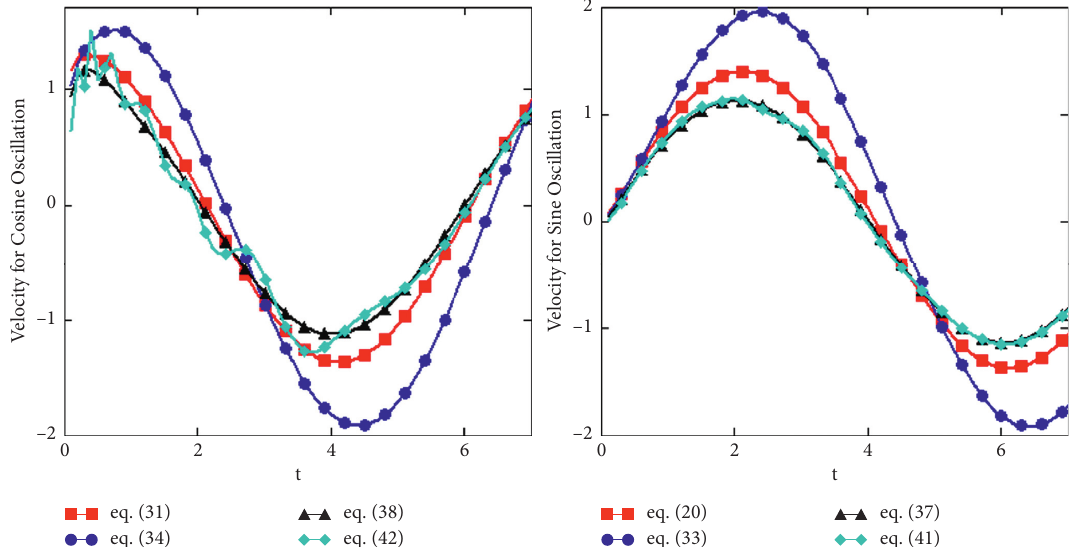
Figure 7: Velocity profiles of fractional Oldroyd-B fluid, classical Oldroyd-B fluid, fractional Maxwell fluid, and classical Maxwell fluid for both cos and